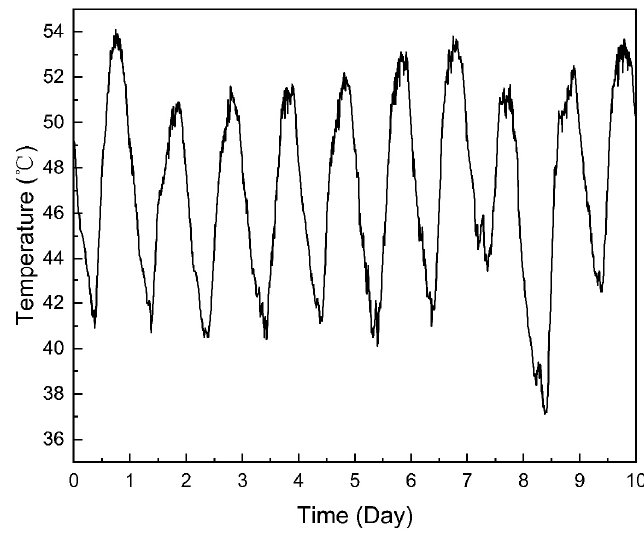
Figure 4. Inlet Temperature.